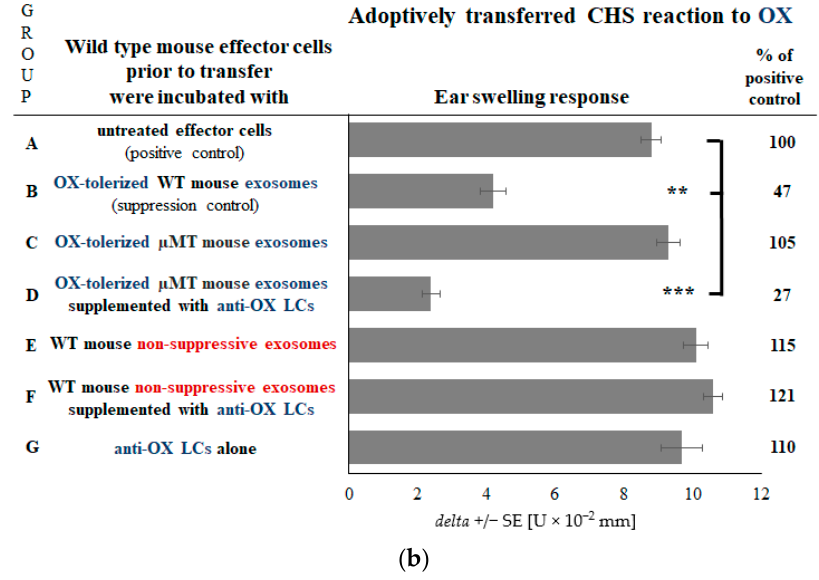
Figure 1. Effects of intravenous administration of a high dose of oxazolone (OX)-coupled syngeneic mouse red blood cells (MRBC) to wild type (C57BL/6) or B cell-deficient µMT mice on contact hypersensitivity (CHS) reaction. CHS reaction was measured as ear swelling response either ( a ) in actively sensitized mice that had been administered with OX-MRBC or ( b ) in recipients of CHS effector cells incubated with exosomes (in some instances supplemented with anti-OX antibody light chains—LCs) generated by lymph node and spleen T suppressor cells of mice injected with OX-MRBC. Bars express delta ± standard error (SE). n = 5 mice in each group. ** p < 0.01; *** p < 0.001.